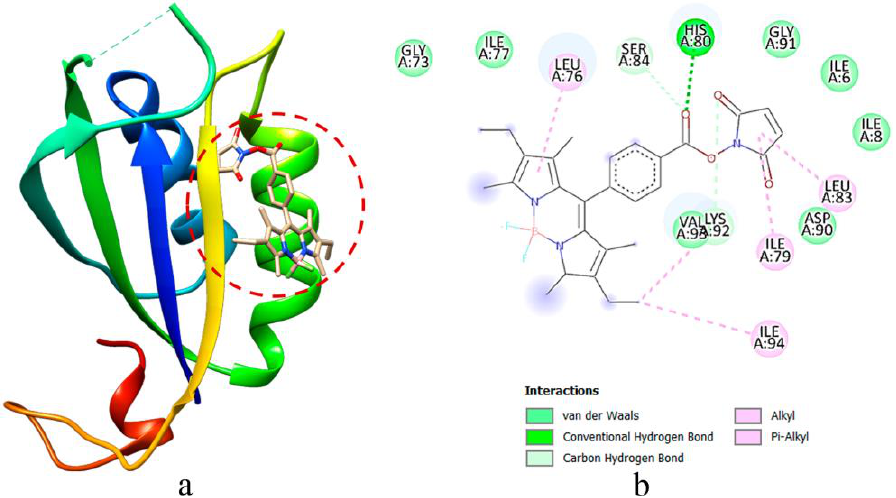
Figure 11. Binding site of NHS-Ph-BODIPY in PotN ( a ) and its amino acid composition ( b ) according to blind docking results.